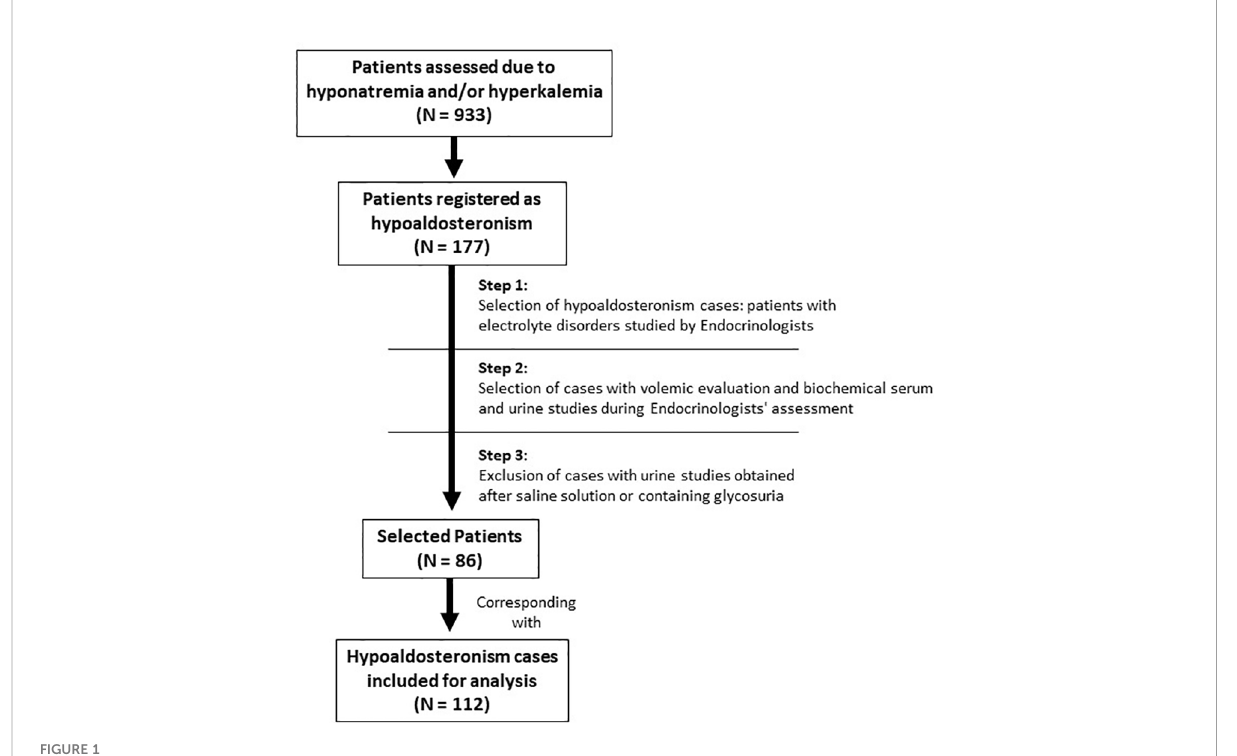
FIGURE 1 Algorithm of